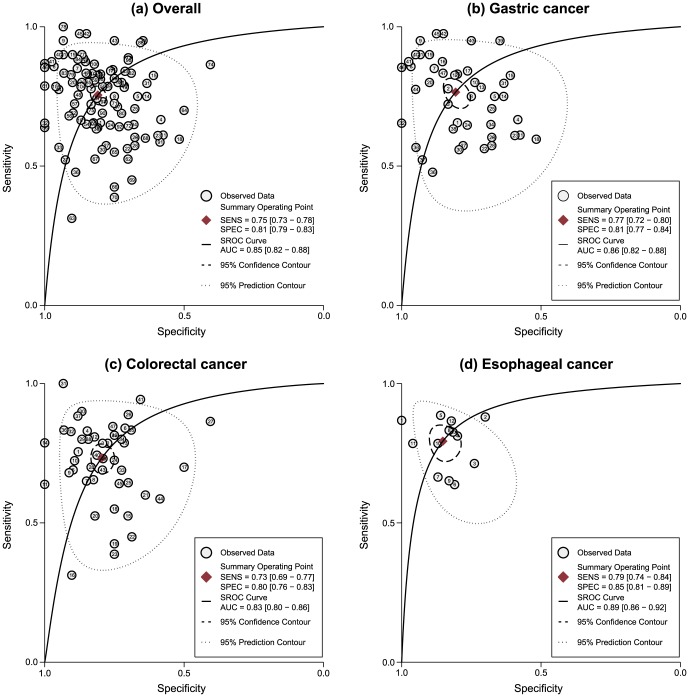
SROC curve with pooled estimates of sensitivity, specificity and AUC (a: overall studies on gastrointestinal cancers; b: GC; c: CRC; d: EC).